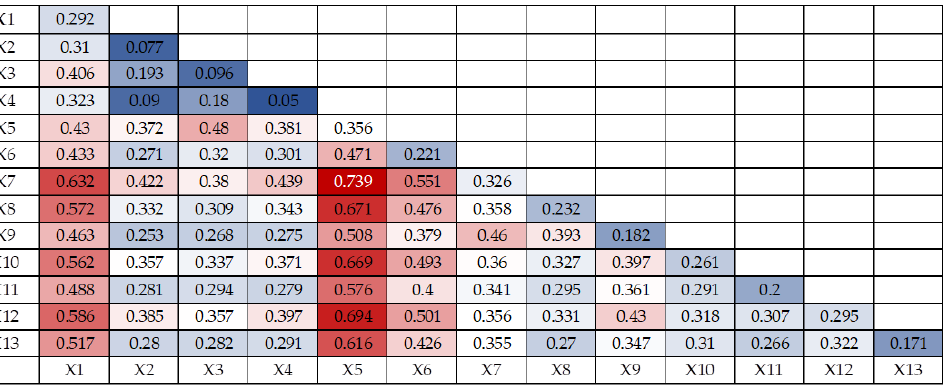
Figure 6. Ecological Vulnerability Interaction Detector Results in Shenyang in 2010.